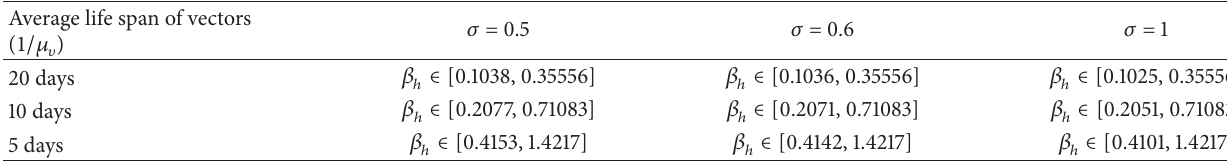
Table 2: Backward Bifurcation Ranges for 𝛽 ℎ for Various Values of 1/𝜇 𝑣 and 𝜎